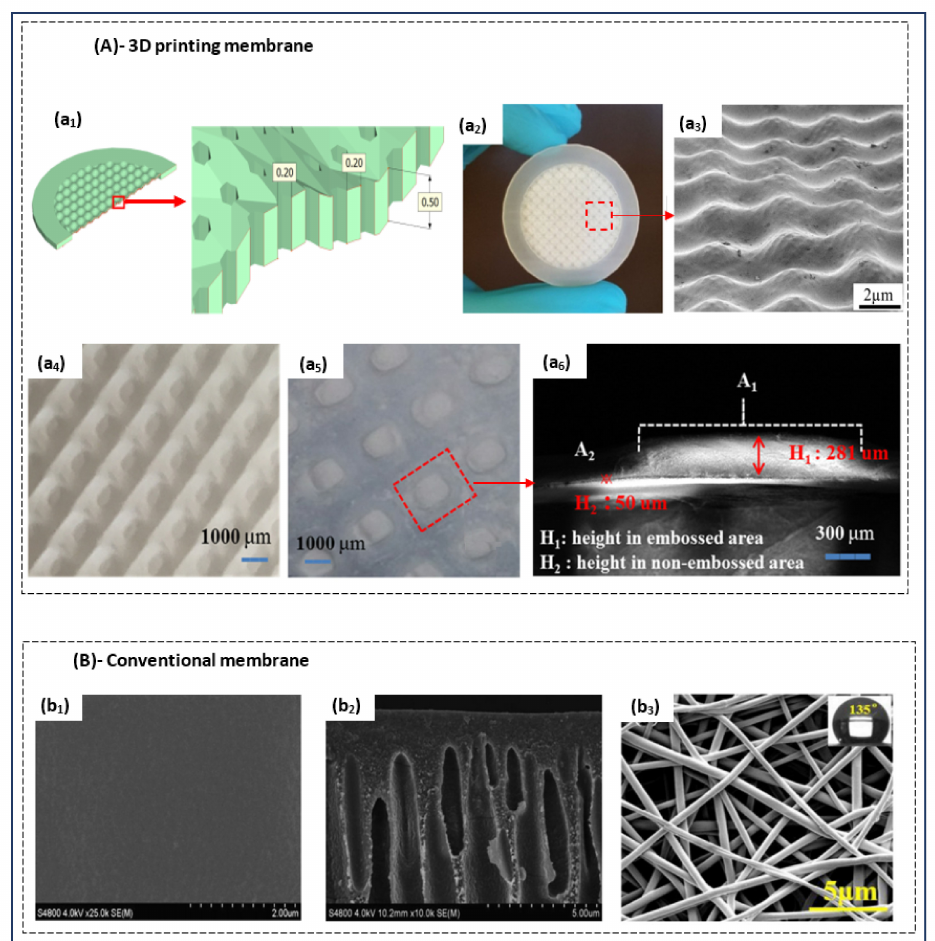
Figure 4. Structures of ( A ) 3D-printed and ( B ) conventional membranes. ( a1 , a2 ) 3D membrane support and its CAD, respectively; ( a3 – a6 ) 3D-printed membranes surface structures [31,37]; Repro- duced with permission from Koh, E.; Lee, Y.T. Development of an Embossed Nanofiber Hemodialysis Membrane for Improving Capacity and Efficiency via 3D Printing and Electrospinning Technology, Separation and Purification Technology; published by Elsevier, 2020. Reproduced with permission from Al-Shimmery, A.; Mazinani, S.; Ji, J.; Chew, Y.M.J.; Mattia, D., 3D Printed Composite Membranes with Enhanced Anti-Fouling Behaviour, Journal of Membrane Science; published by Elsevier, 2019. ( b1 ) surfaces of a conventional membrane, ( b2 ) SEM micrographs of cross-sections of conventional membranes (phase inversion) [43] Reproduced with permission from Zhu, L.-J.; Liu, F.; Yu, X.-M.; Gao, A.-L.; Xue, L.-X. Surface Zwitterionization of Hemocompatible Poly(Lactic Acid) Membranes for Hemodiafiltration. Journal of Membrane Science; Elsevier 2015. ( b3 ) SEM images of the surface of electrospinning membrane [44] Reproduced with permission from Zhang, Z.-M.; Gan, Z.-Q.; Bao, R.-Y.; Ke, K.; Liu, Z.-Y.; Yang, M.-B.; Yang, W. Green and Robust Superhydrophilic Electrospun Stereocomplex Polylactide Membranes: Multifunctional Oil/Water Separation and Self-Cleaning, Journal of Membrane Science; Elsevier,